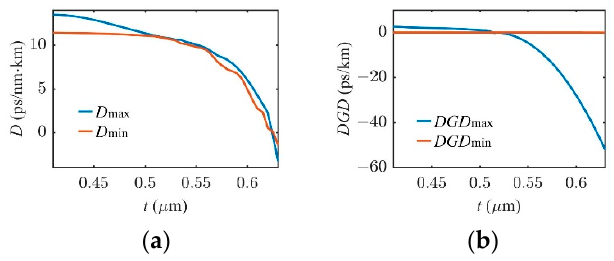
Figure 9. ( a ) Change in D with t ; ( b ) Change in DGD with t .